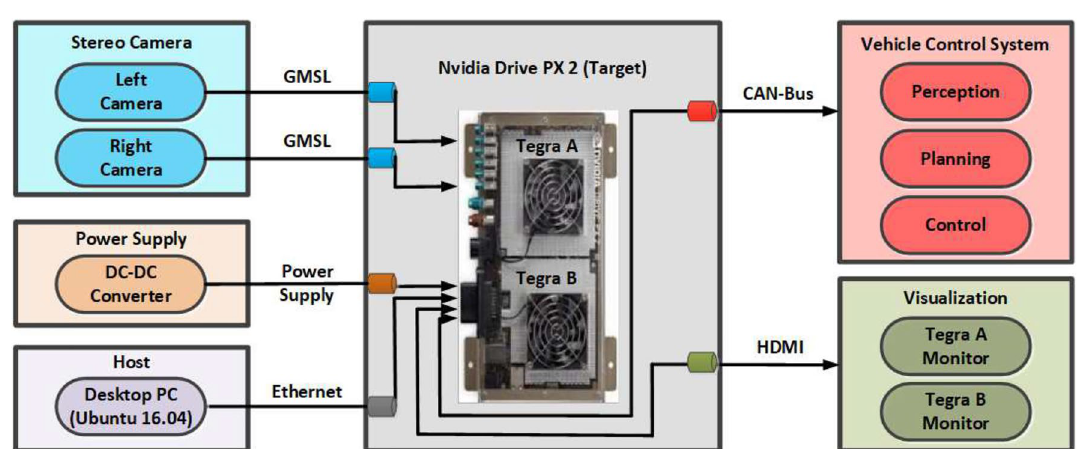
Fig. 13 Hardware interface diagram of the stereo vision